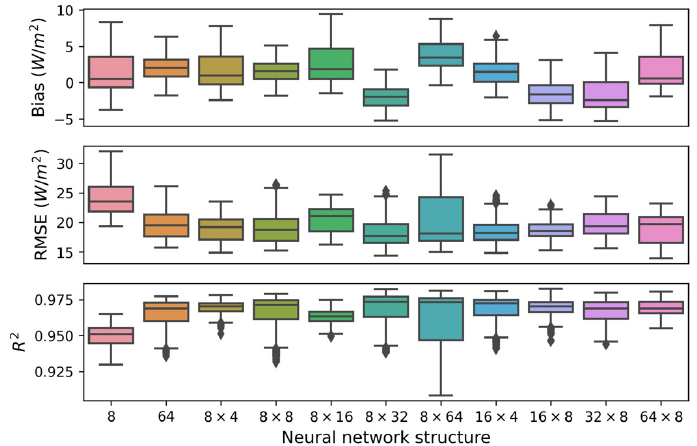
Figure 3. Performances of different neural network (NN) structures for surface upward longwave radiation (SULR) estimation. The metrics are bias, root mean square error (RMSE), and R 2 from top to bottom. Each NN structure was trained 10 times. The “8” indicates a single hidden layer with eight neurons, and “8 × 4” indicates two hidden layers in which the first layer has eight neurons, and the second layer has four neurons. The 16 × 8 structure showed the best performance.